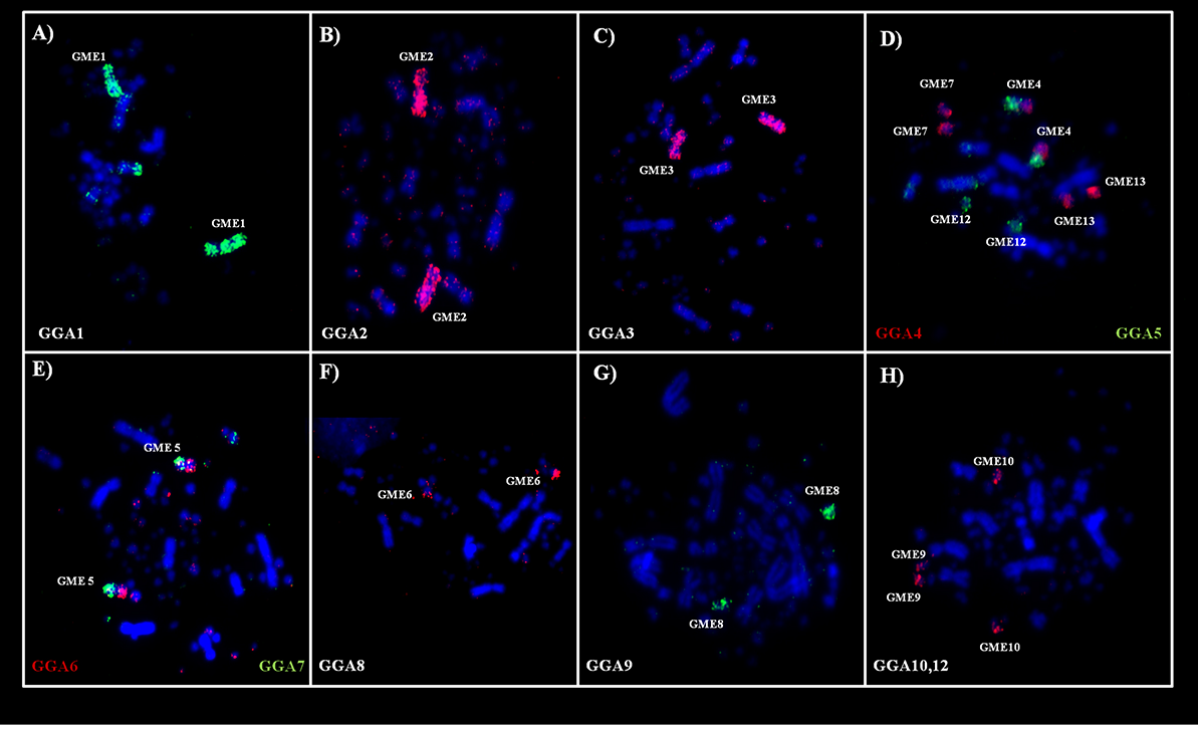
Figure 2 – FISH using whole-chromosome Gallus gallus probes on metaphases of Gallinula melanops . A-C and F-H are examples of conserved chromosomes, while D-E are examples of fusions and fissions. (D) GME4=GGA4 + GGA5 => fusion; GGA4 = GME4p + GME7+ GME13 => fission; GGA5 = GME12 + GME4q => fission; and (E) evidence that GGA6 + GGA7 = GME 5 =>